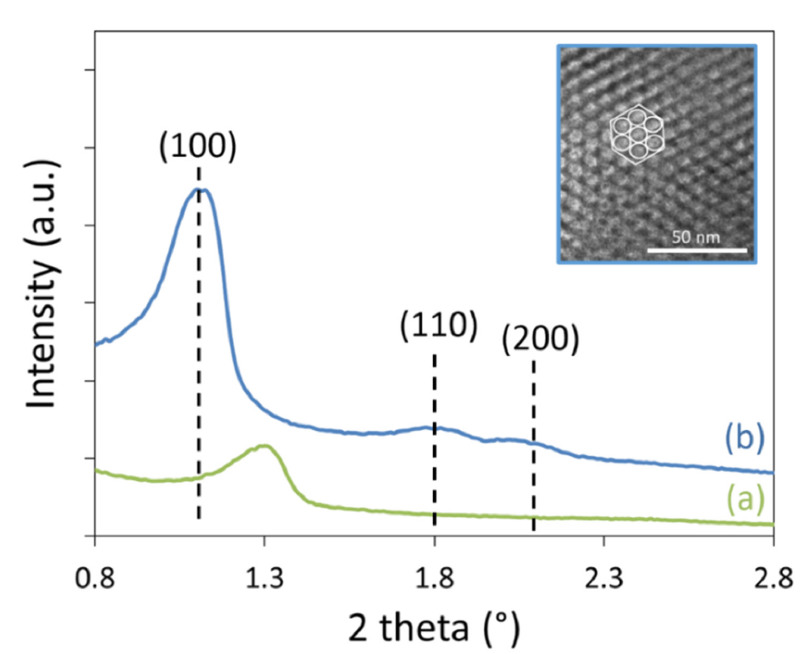
Figure 5. Small-angle XRD patterns of ( a ) Ni/SBA-15(N), and ( b ) Ni/SBA-15 HT (N). Inset: TEM image of Ni/SBA-15 HT (N) showing the two-dimensional (2D) hexagonal arrangement.